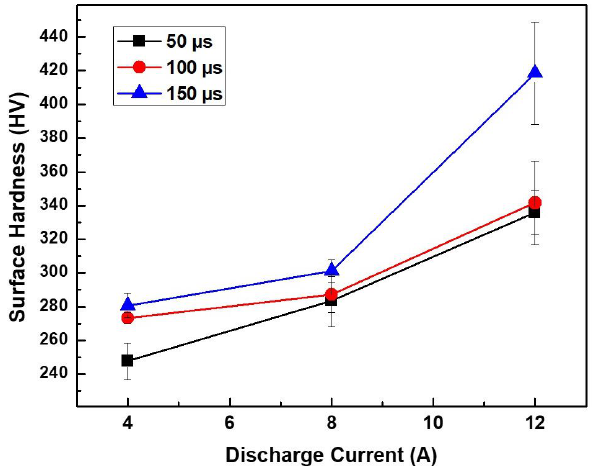
Figure 4: The relationship between discharge current and surface hardness of BMG machined surface under different pulse-on time